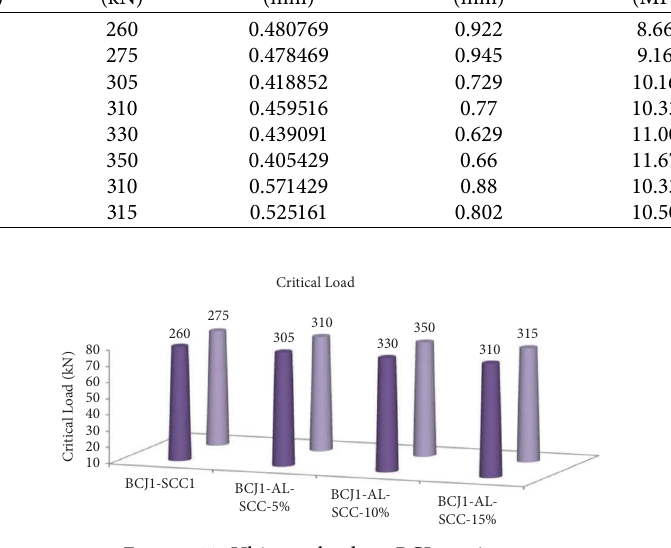
Figure 11: Ultimate load vs. BCJ specimens.